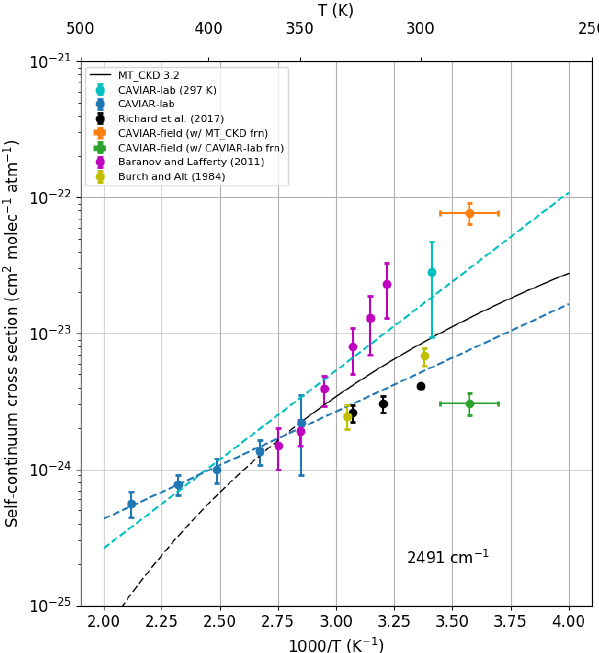
Figure 13. Self-continuum absorption cross section against temper- ature for various datasets at 2491cm − 1 . The error bars indicate the k = 1 uncertainties. Marker size is greater than the stated uncer- tainty where error bars are not visible. The dashed black line of MT_CKD above 350K indicates the region outside of the expected applicability of MT_CKD. The dashed blue line indicates extrapola- tion of the high-temperature CAVIAR-lab temperature dependence, while the cyan dashed line shows the extrapolation through all of the CAVIAR-lab data points (including the low-temperature cyan data